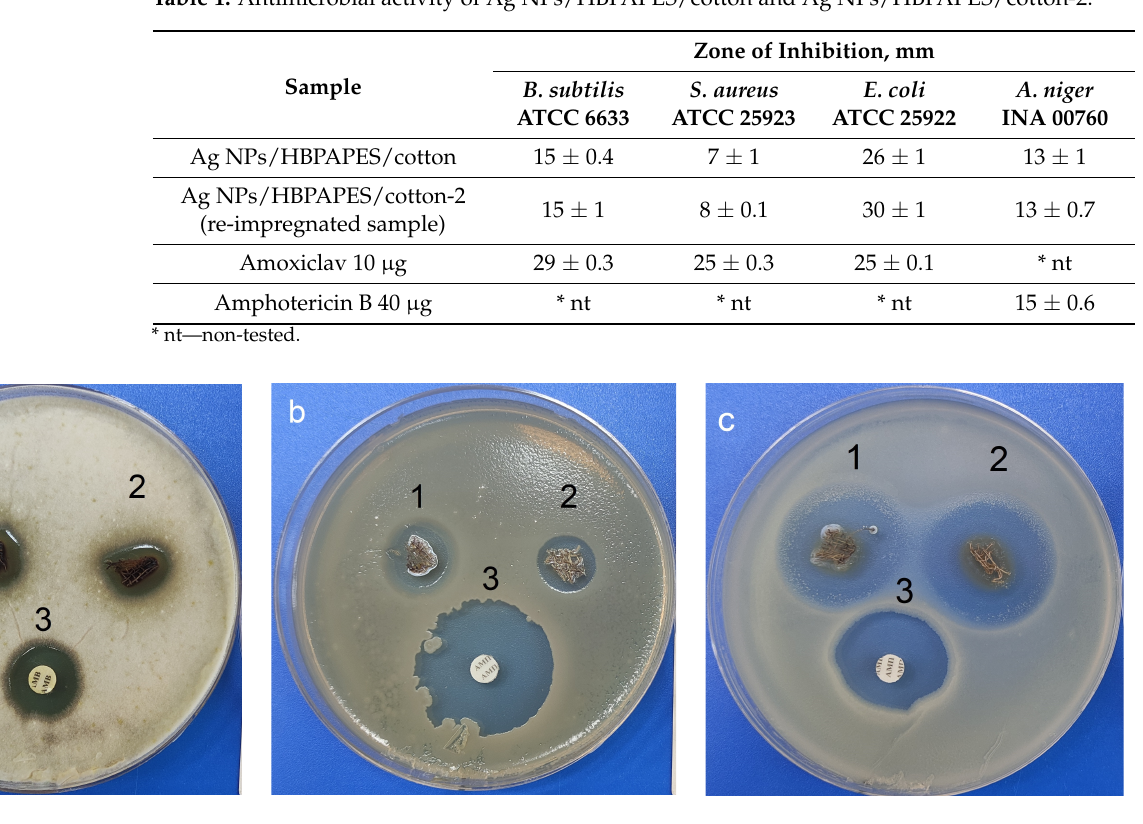
Figure 15. Antimicrobial activity: ( a ) 1 ‐ Ag NPs/HBPAPES/cotton; 2 ‐ Ag NPs/HBPAPES/cotton ‐ 2; 3 ‐ amphotericin B;. ( b , c ) 1 ‐ Ag NPs/HBPAPES/cotton; 2 ‐ Ag NPs/HBPAPES/cotton ‐ 2 ; 3 ‐ amoxiclav. A. niger INA 00760, B. subtilis ATCC 6633, E. coli ATCC 25922. Table 1. Antimicrobial activity of Ag NPs/HBPAPES/cotton and Ag NPs/HBPAPES/cotton ‐ 2.